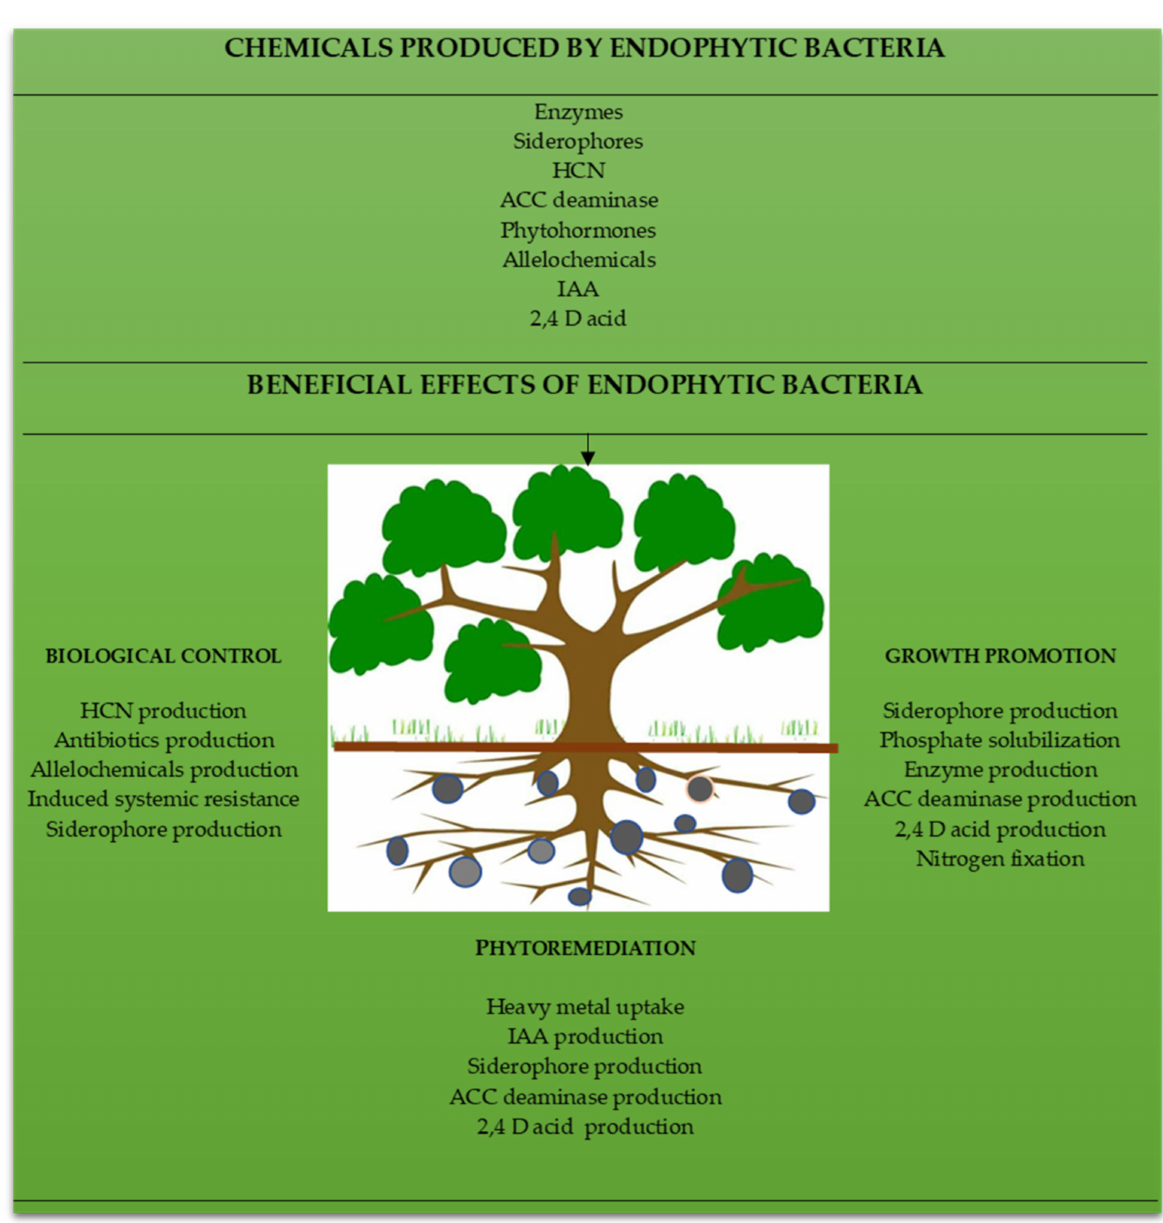
Figure 1. Roles of endophytic bacteria on plant growth, protection, and